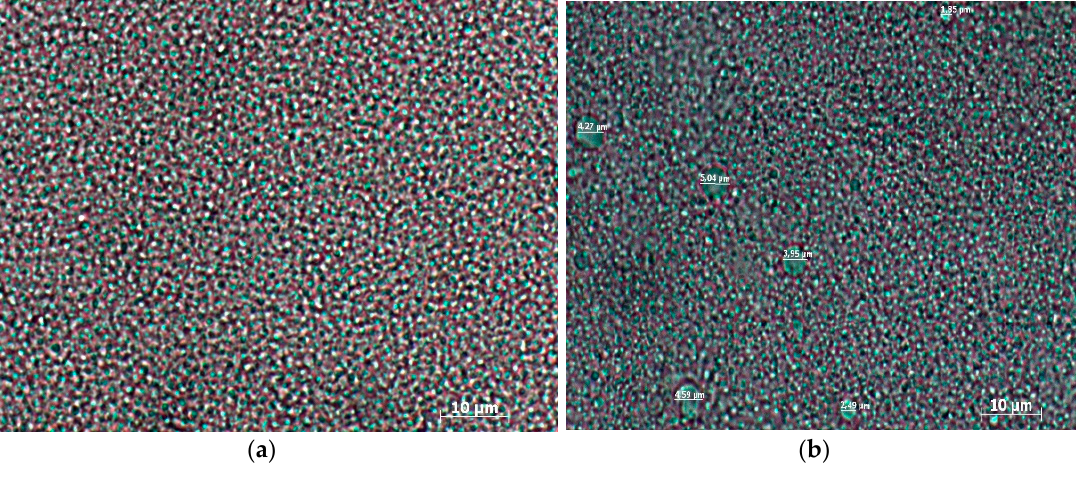
Figure 4. Optical microscopy of CX0 ( a ) and CX2 ( b ).